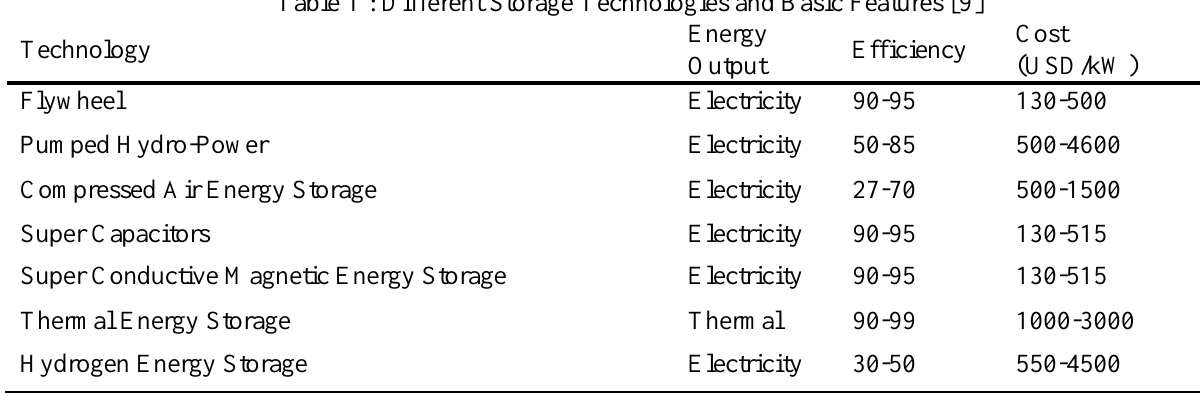
Table 1 : Different Storage Technologies and Basic Features